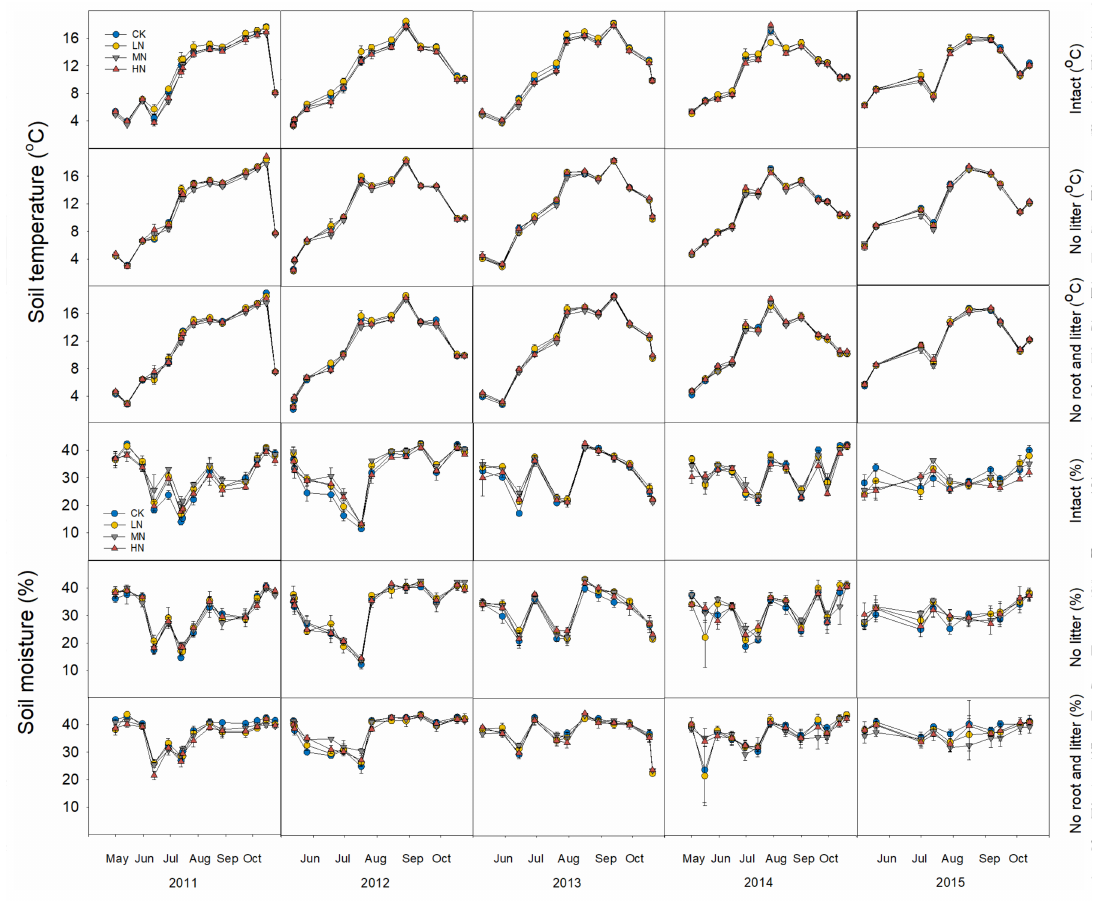
Figure A1. Dynamics of soil temperature and moisture from May 2011 to October 2015 in a Pinus tabulaeformis